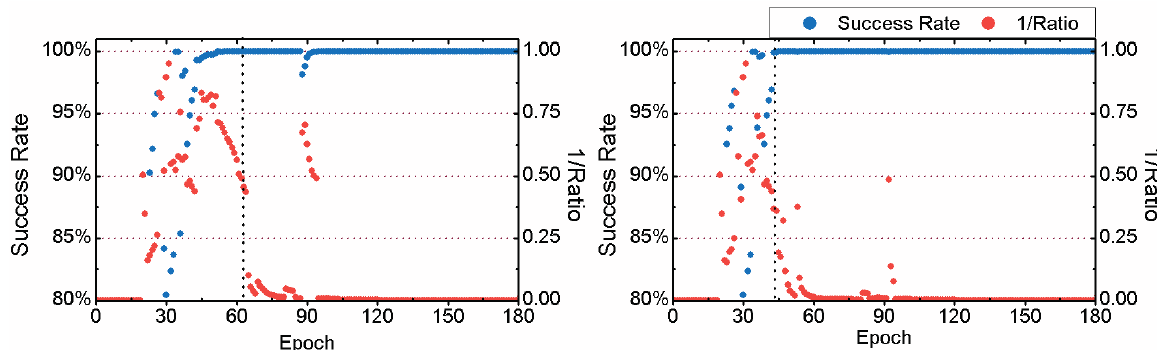
Figure 5. Success rate and reciprocal of the ratio test value for for static PPP for the observations of the 6th session from MAS1 on 24 January 2012, achieved by FAR ( Left ) and PAR ( Right ), respectively.